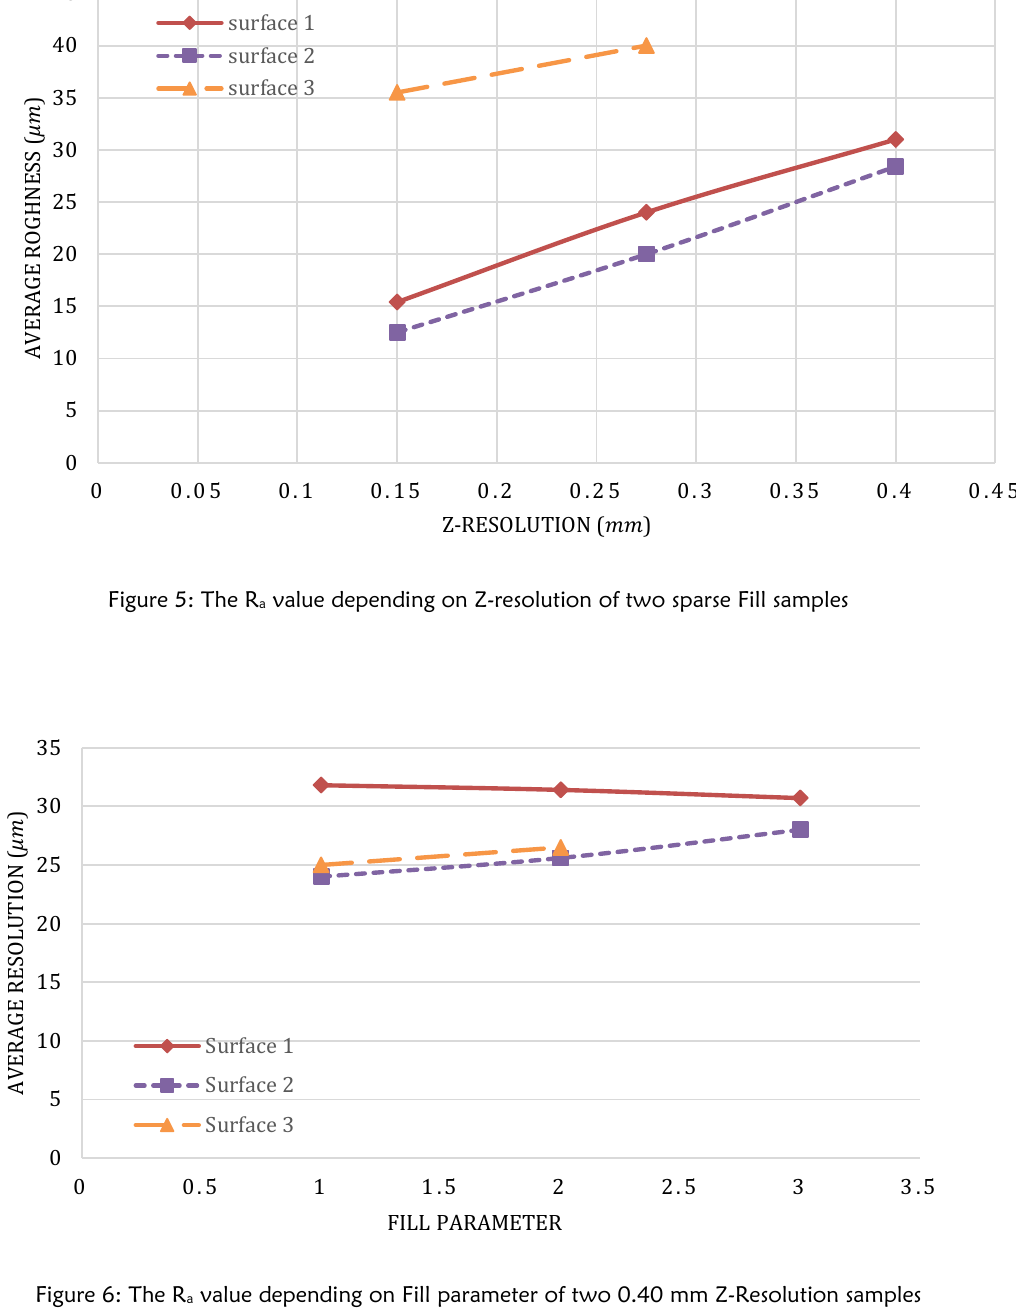
Figure 6: The R a value depending on Fill parameter of two 0.40 mm Z-Resolution